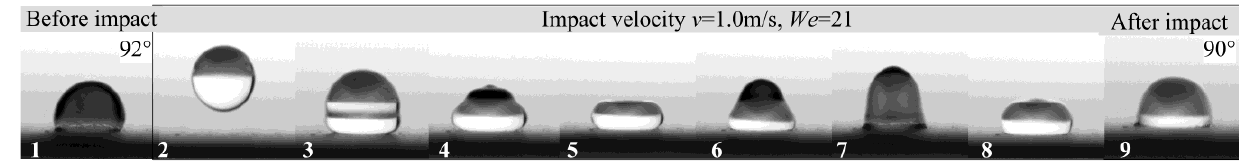
Figure 8. Digital microscopic images of droplet contact on the BLSH surfaces. ( a , b ) Contact mor- phologies of the droplet; ( c ) schematic illustration of the droplet contact mode; ( d – f ) enlarged partial views of contact at various magnifications.